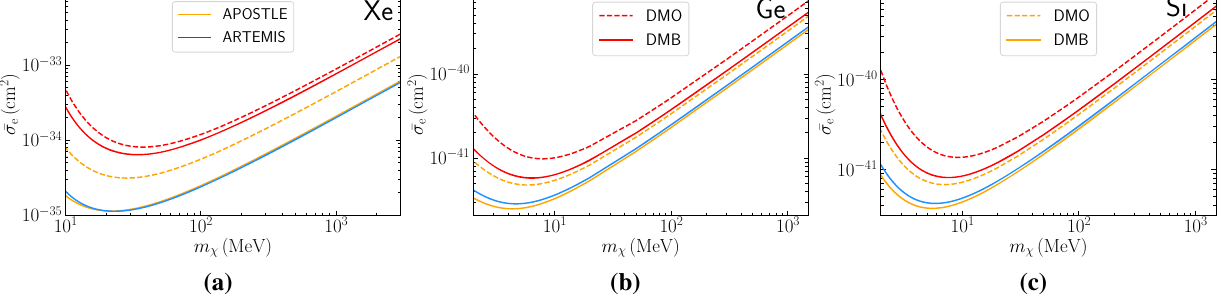
Fig. 8 Same as Fig. 7 but for F DM ∝ q − 2